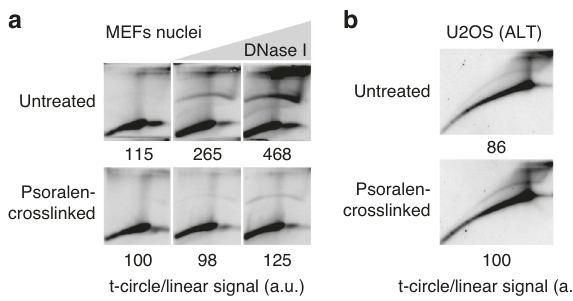
Fig. 6 I-loop formation after DNA damage requires branch migration. a A preparation of SV40LT-immortalized MEFs nuclei was split in two and one half was psoralen crosslinked on ice (in this prep, DNA branch migration is largely prevented). Then, both preps were treated with DNase I and processed for 2D-gels as described in Fig. 5a. The ratio of the telomeric signal in the t-circle arc and in the linears is reported relative to the untreated and crosslinked sample, which was arbitrarily set to 100. Source data are provided as a Source Data File. b 2D-gel analysis showing that the i-loops that accumulate in ALT cells are not affected by psoralen crosslinking. U2OS cells were psoralen crosslinked on ice, then genomic DNA was extracted and processed for 2D-gels as above. The ratio of the telomeric signal in the t-circle arc and in the linears, is reported relative to the crosslinked sample which was arbitrarily set to 100. Source data are provided as a Source Data